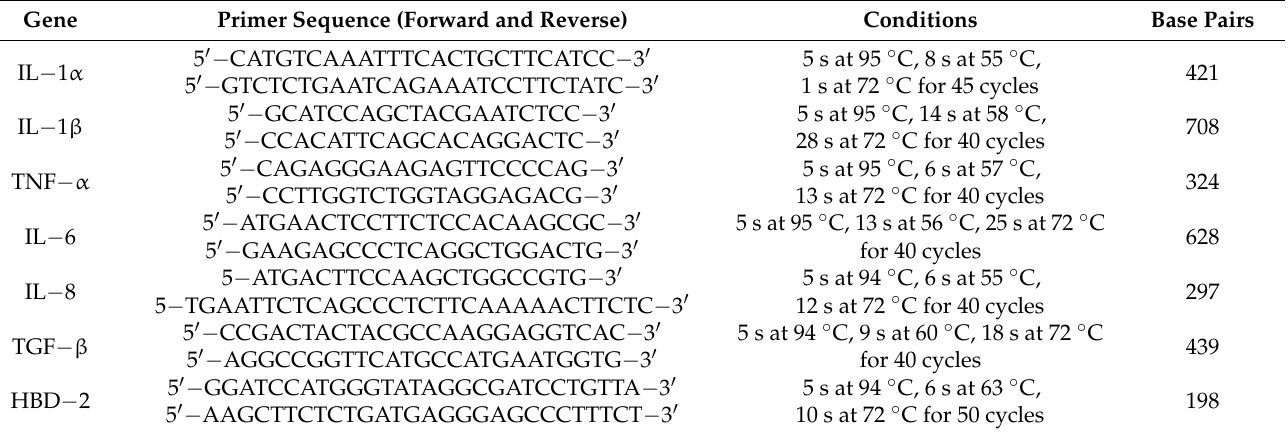
Table 2. Analyzed genes and RT-PCR conditions to assess the inflammatory and immune response of HaCaT cells exposed to the different CN-treated PEOT/PBT and PEOT/PBT/(CN/PEG) scaffolds.